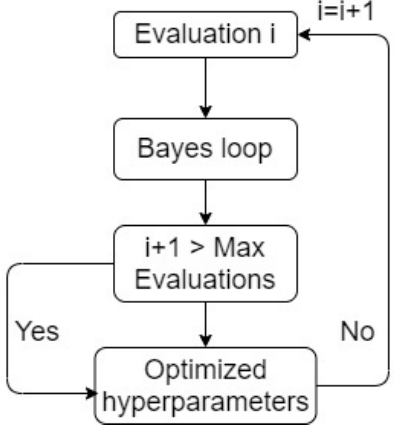
Figure 2. Schematic of SMBO.